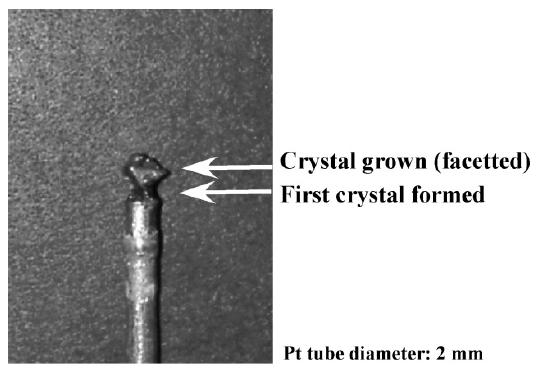
Figure 3. Crystal grown by the new technique, reprinted with permission from